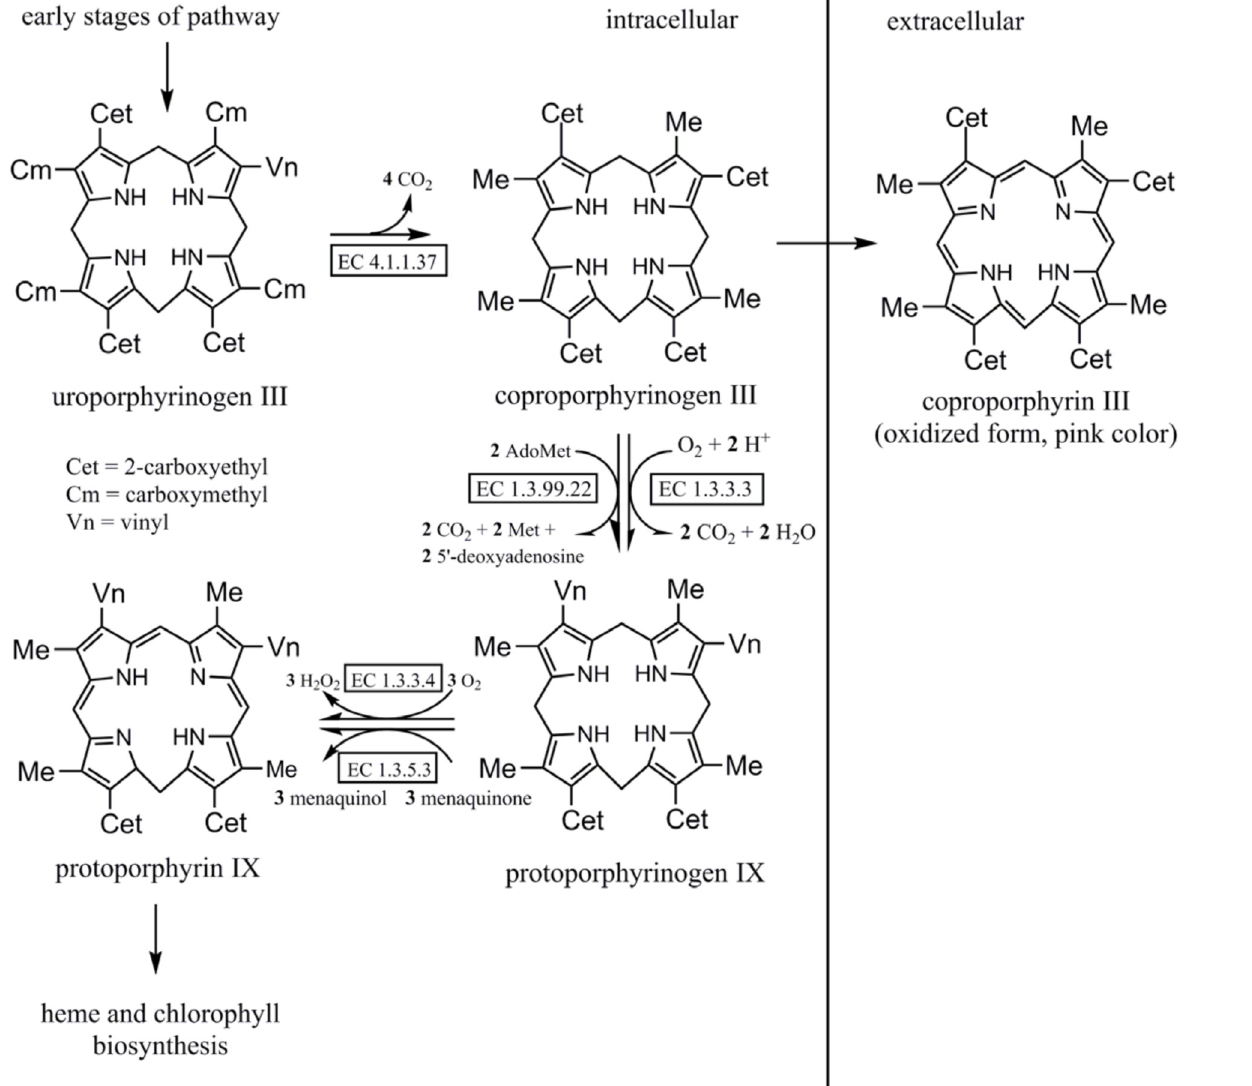
Fig 5. Later stages of the biosynthetic pathway of porphyrin. The enzymes catalyzing each step are indicated (adapted from IUBMB) [23].